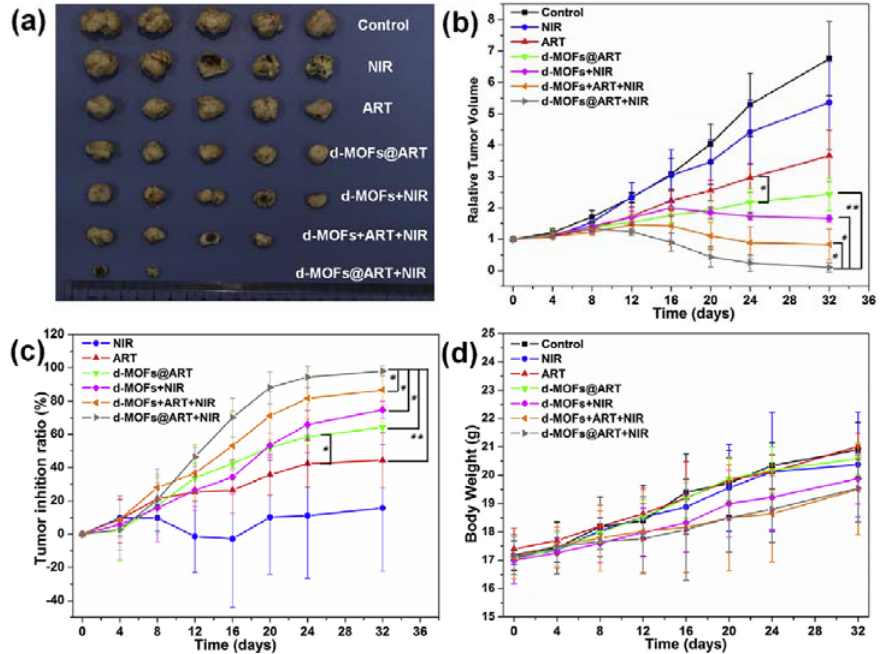
Figure 9. Antitumor ability of ART-loaded d-MOFs nanospheres in HeLa xenograft mice models. ( a ) The excised tumors from different mice groups treated with saline, NIR irradiation, free ART, d-MOFs@ART, d-MOFs + NIR, d-MOFs + ART + NIR (non-encapsulated) and d-MOFs@ART + NIR at 32nd day; ( b ) Tumor growth curves of mice after various treatments (mean ± SD., n = 5, * p < 0.05, ** p < 0.01); ( c ) Tumor inhibition ratio of the NIR irradiation, free ART, d-MOFs@ART and d-MOFs + NIR group and d-MOFs@ART + NIR tumor inhibition ratio of chemo-thermal therapy (mean ± SD., n = 5, * p < 0.05, ** p < 0.01); ( d ) Body weights of mice for varied time periods for 32 days after various treatments. ART = artemisinin. d-MOFs = dual metal organic frameworks. Reproduced with permission from [107]. Elsevier,